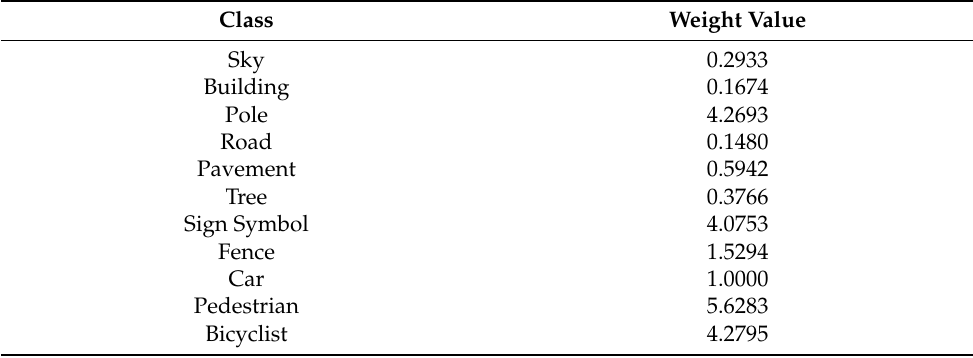
Figure 6. Class Distribution in the CamVid Dataset (Semi-dark Images). Table 5. Class Weights for Handling Biased Network